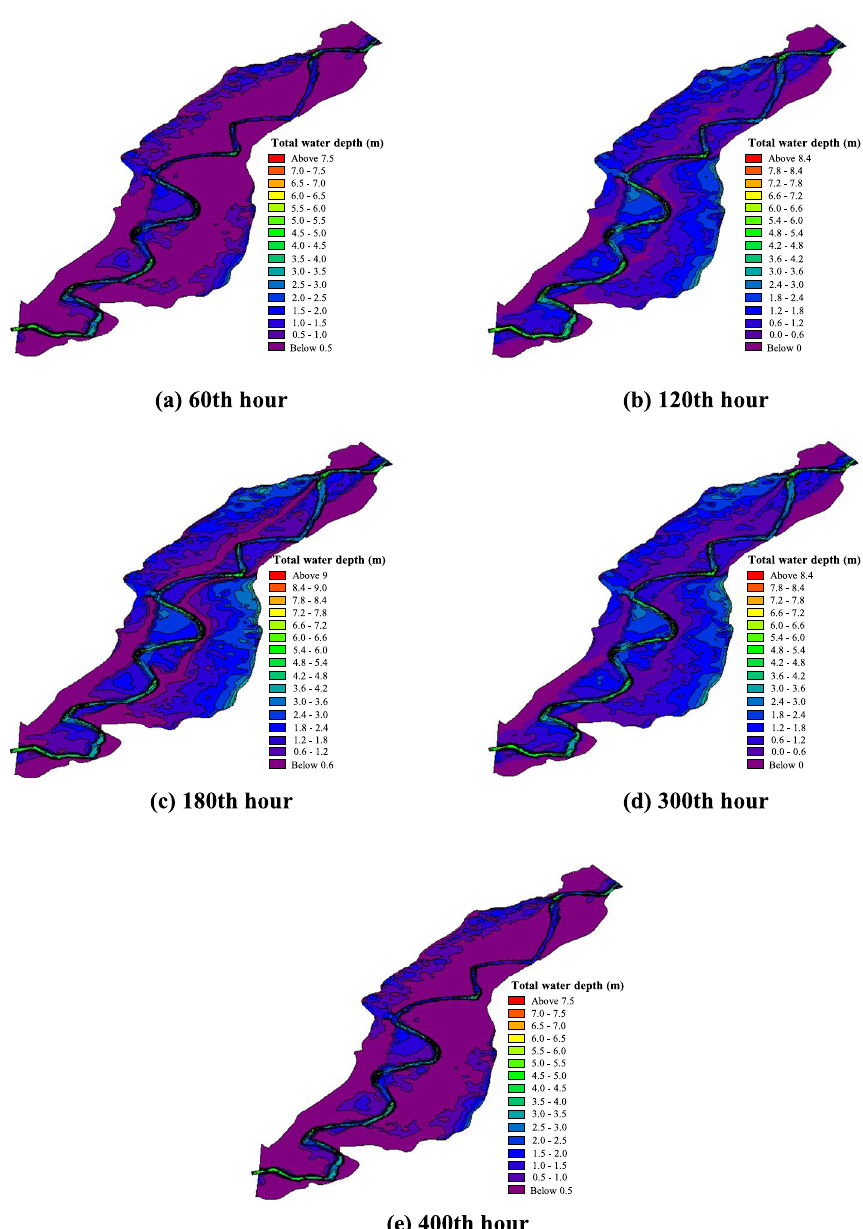
Fig. 10 Water depth and inundation range under “96.8” flood. a 60th h. b 120th h. c 180th h. d 300th h. f 400th